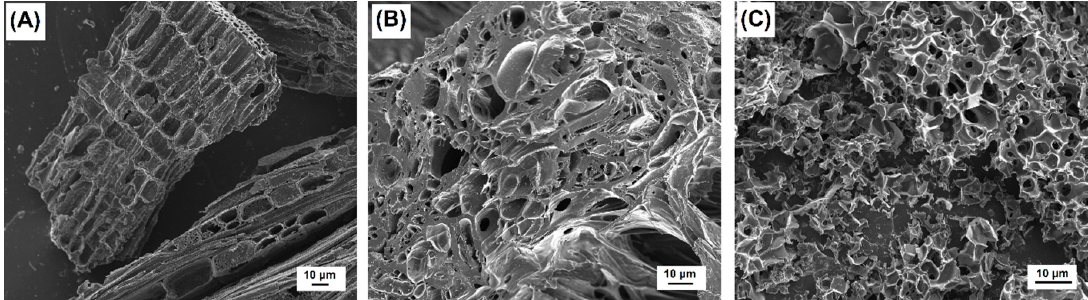
Figure 2. High-resolution scanning electron microscopy (HRSEM) images of: ( A ) SDC-AC, ( B ) OSC-AC, and ( C ) OS-AC/KOH supports (without Fe). Samples’ porosity was determined by N 2 and CO 2 -adsorption isotherms and the